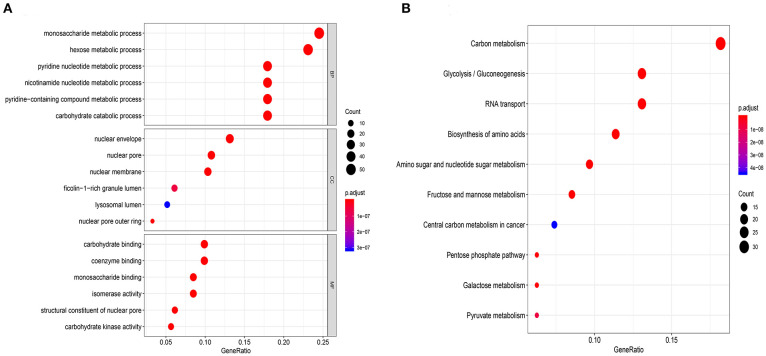
Functional enrichment analysis of glycolysis-related genes chose from GSEA. (A) Gene ontology biological process terms, (B) Enrichment of KEGG pathways. P < 0.05 was set as the cutoff criteria.